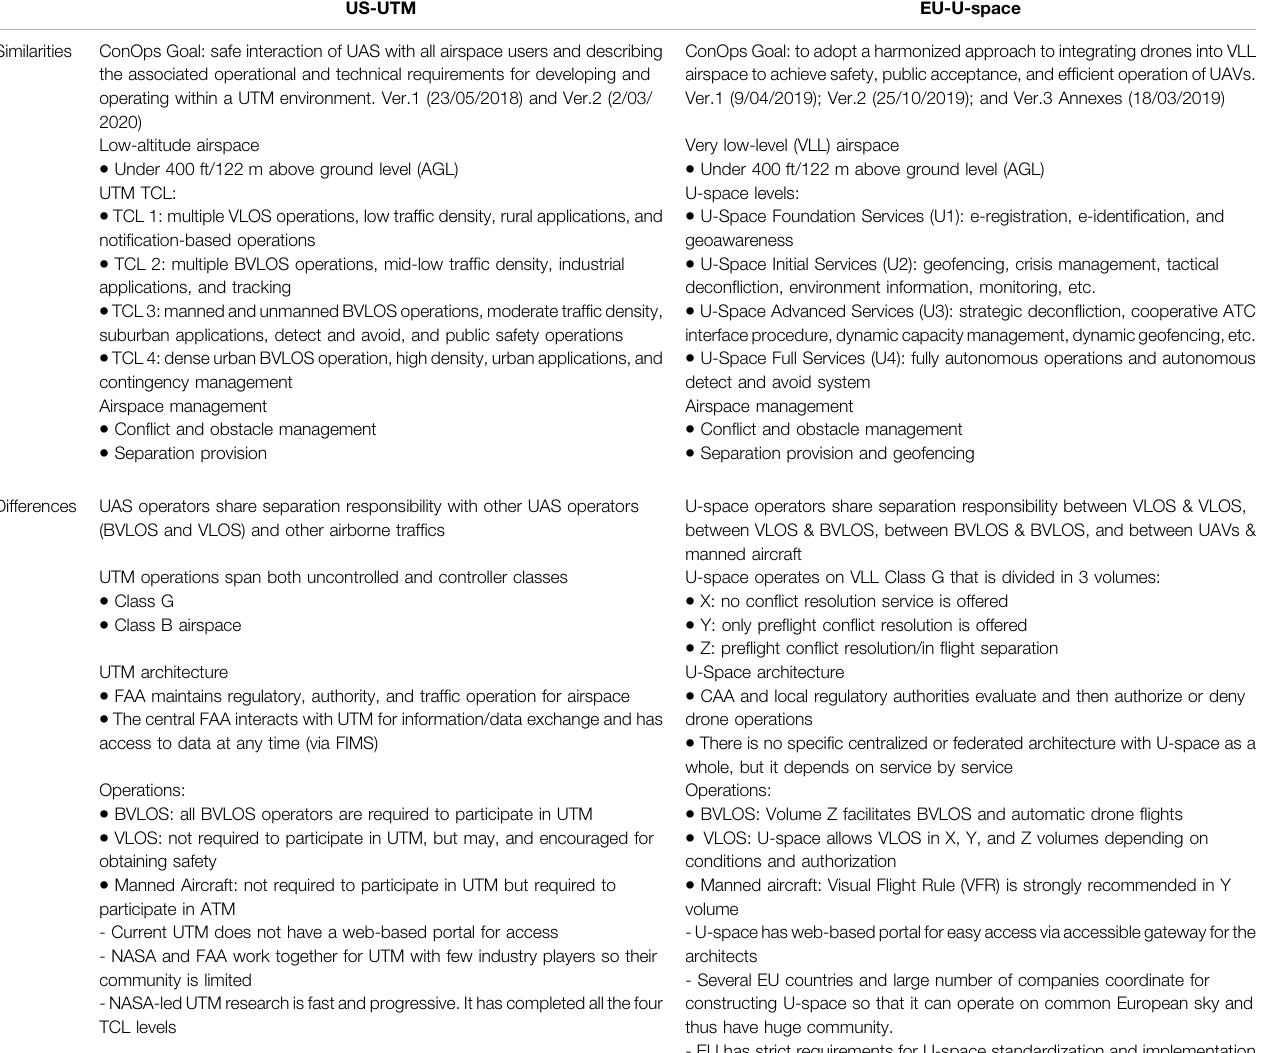
TABLE 5 | Comparison between US-UTM and EU-U-space. US-UTM EU-U-space Similarities ConOps Goal: safe interaction of UAS with all airspace users and describing ConOps Goal: to adopt a harmonized approach to integrating drones into VLL the associated operational and technical requirements for developing and airspace to achieve safety, public acceptance, and ef fi cient operation of operating within a UTM environment. Ver.1 (23/05/2018) and Ver.2 (2/03/ 2020)